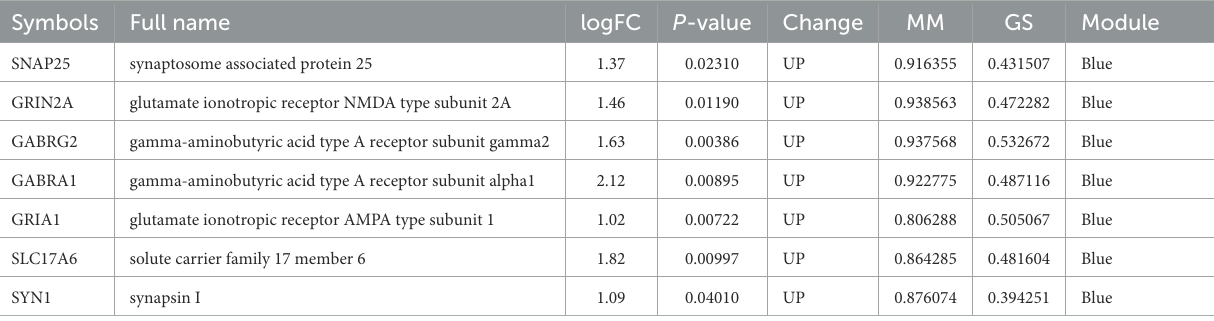
TABLE 1 The information on seven key